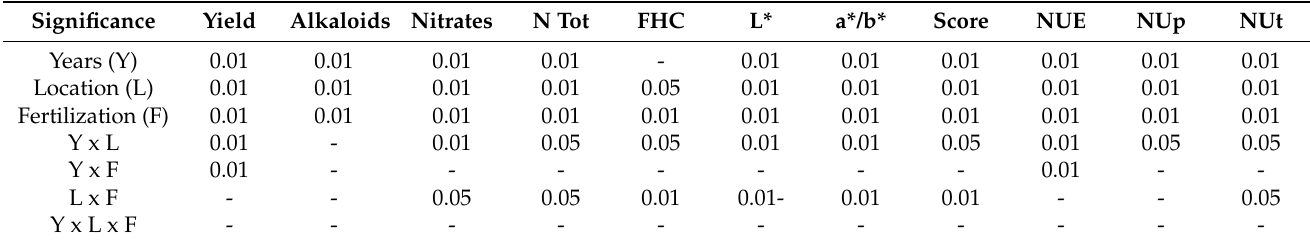
Table 2. Analysis of variance results of yield and cured leaves quality traits. For the explanation of the index, see Materials and Methods section.